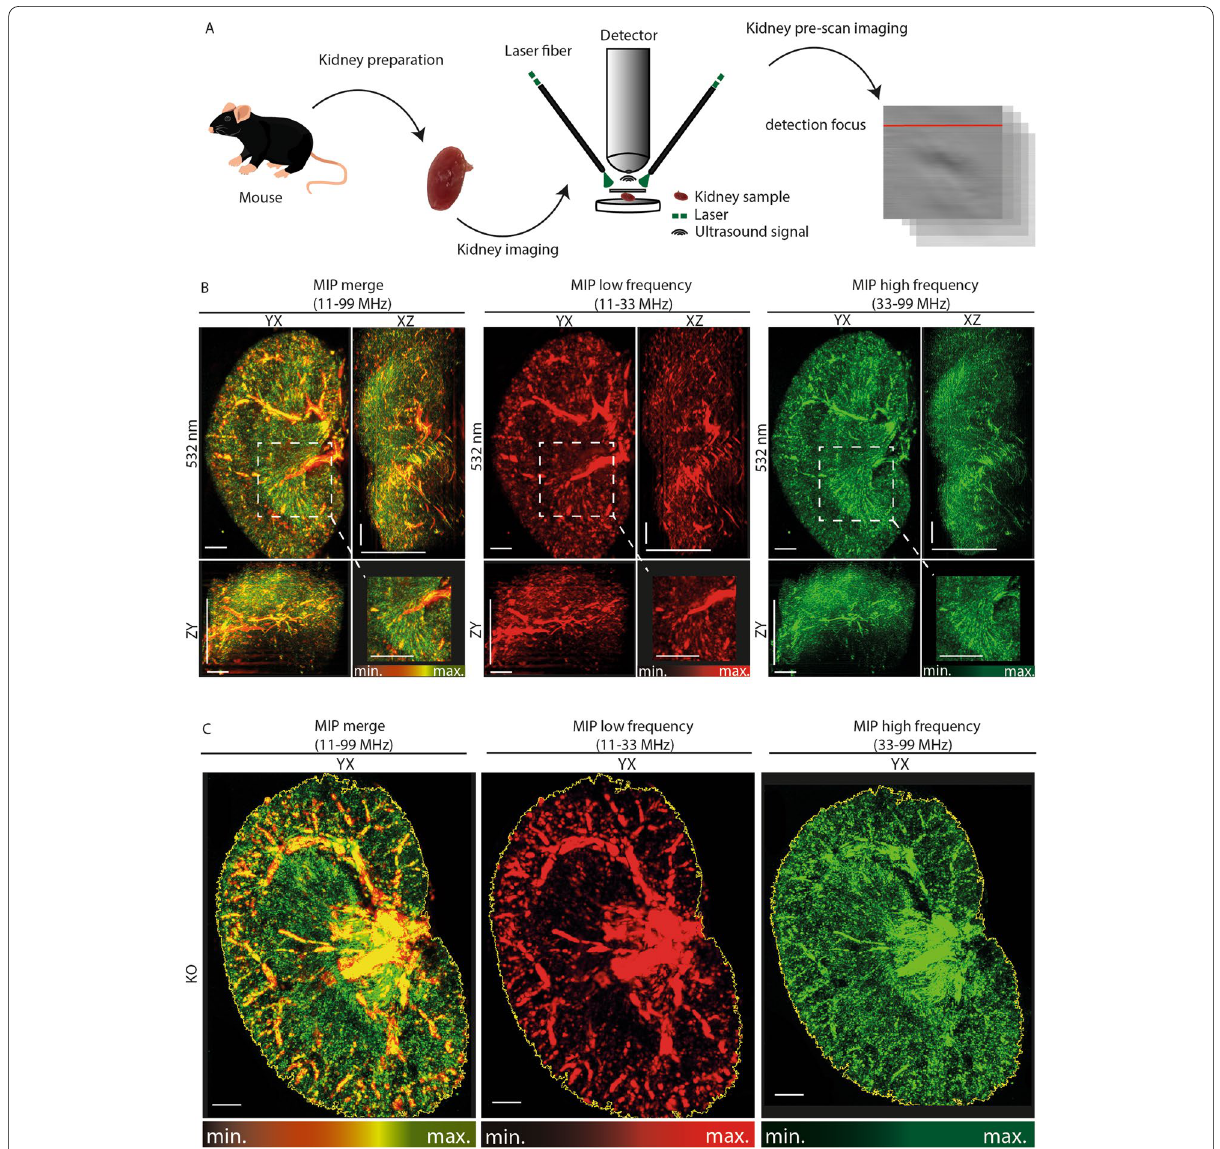
Fig. 1 RSOM imaging work flow and exemplary images of renal vasculature. A Schematic cartoon of the imaging workflow. After cervical dislocation, kidneys were prepared and freshly imaged with the RSOM system. The excised kidney is covered with ultrasound gel and placed under a water bed shielded by a plastic foil. The tissue is illuminated with two 532nm lasers and the generated ultrasound waves are captured by the detector. A pre-scan is conducted before every full scan. Optoacoustic signals are than reconstructed by a dedicated software visualizing mainly haemoglobin molecules and the respective structures filled with it. B Exemplary reconstructed cross-sectional RSOM maximum intensity projections (MIP) of a heterozygotes (HET) mouse kidney are displayed. Merged frequencies (red-green) combine the information from low frequencies (bigger vessels red) and higher frequencies (smaller vessels green) allowing visualization of renal vasculature. All three imaging = = planes (YX, XZ, and ZY) are displayed with a 2-fold magnification of a central kidney section (Rectangle 2x2mm) with a large and many small vessels. Scale bars indicate 1mm. C Exemplary reconstructed cross-sectional maximum intensity projections (MIP) of a knockout (KO) mouse kidney are displayed. A region of interest (outlined in yellow) was automatically drawn around each kidney. The included area was used for further analyses. HET heterozygotes (HET), KO knockout (KO), MIP maximum intensity projection, ROI region of interest, MF merge frequency, LF low = = = = = = frequency, HF high frequency, min. minimum, max. = = =